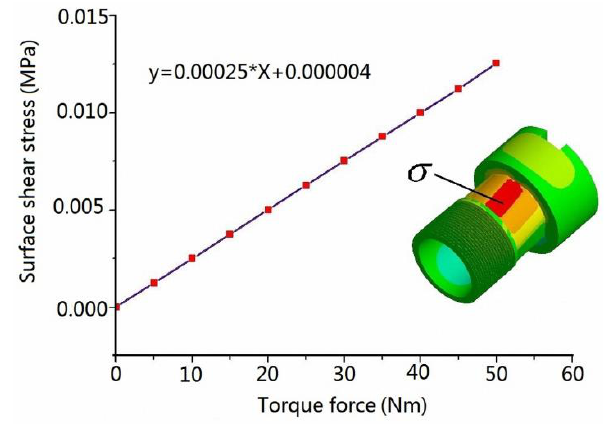
Figure 3. FEM result for the thin-walled cylinder under torque force.